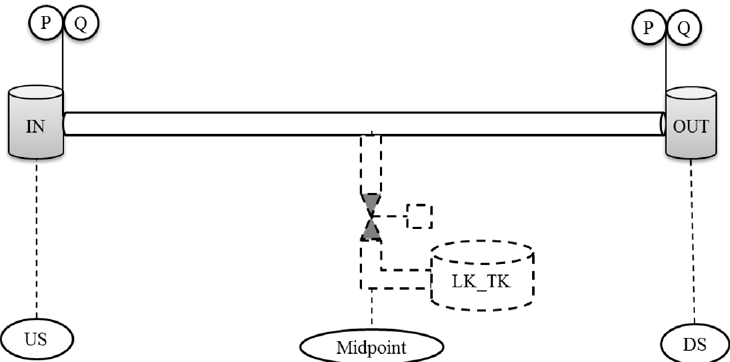
Figure 1. Schematic of the study pipeline with simulated leak.